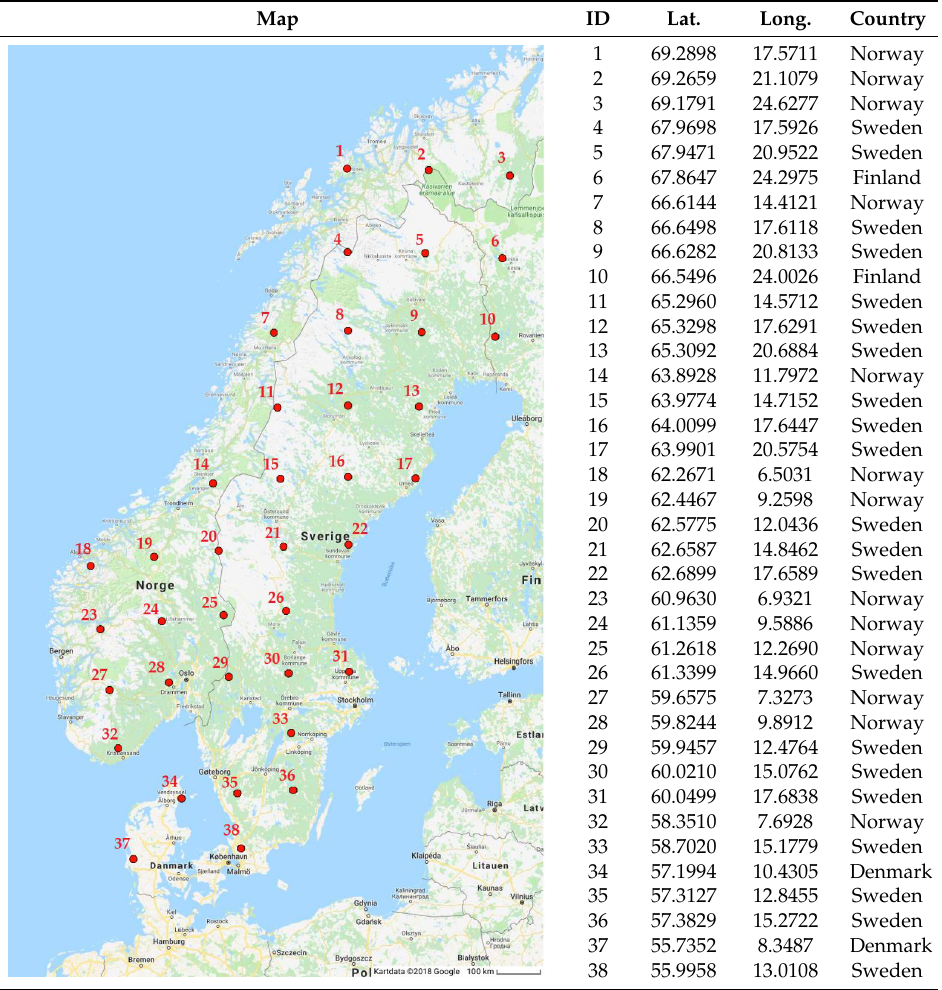
Table 6. The map and the coordinates of the 38 locations extracted from the Climate for Culture project (image generated from [48]).